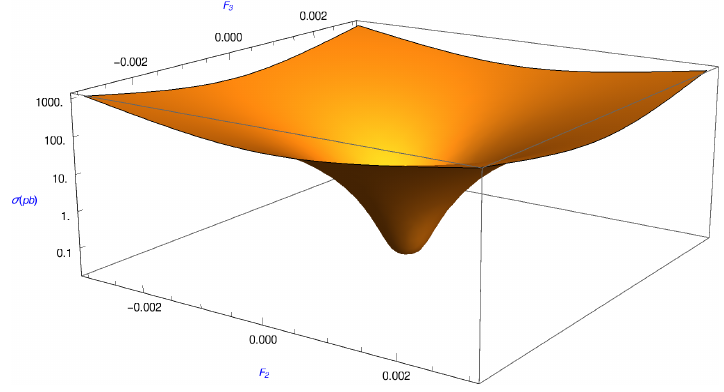
(cid:112) s = 13 TeV .